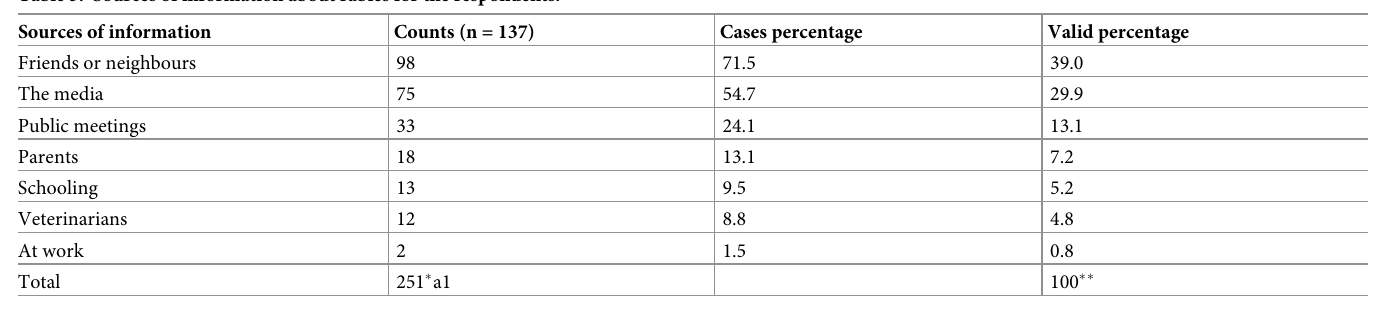
Table 3. Sources of information about rabies for the respondents.